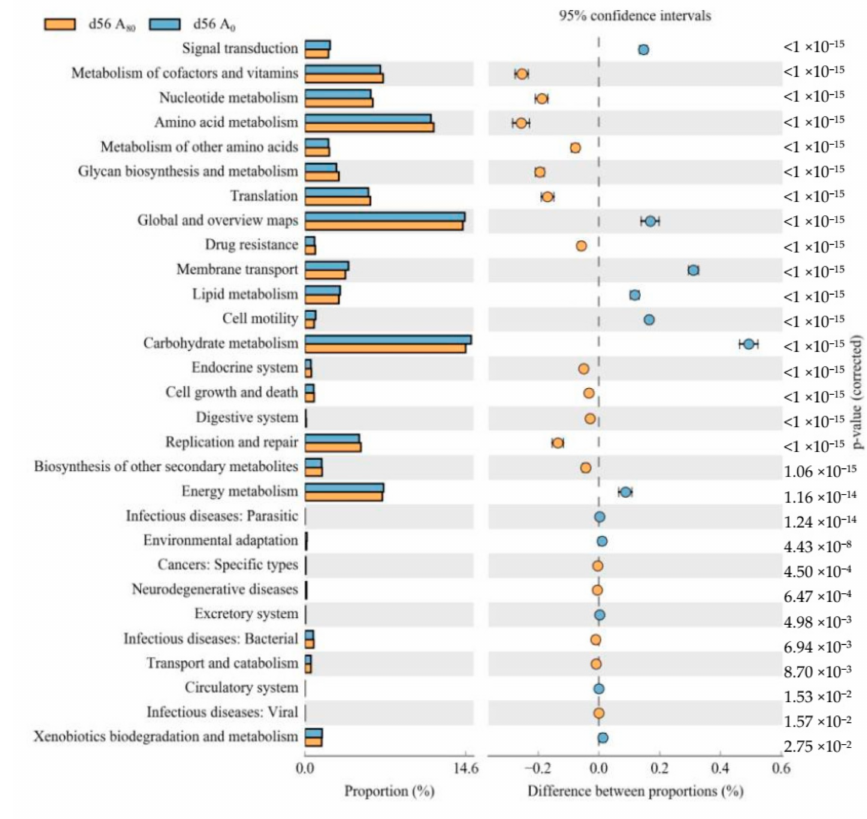
Figure 2. Kyoto Encyclopedia of Gene and Genomes (KEGG) analysis of rumen bacteria between group A 0 and group A 80 on d